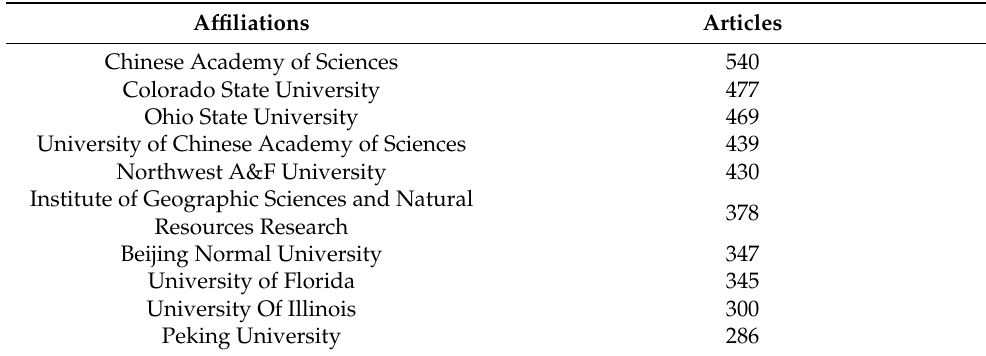
Table 3. Top 10 Research Institutions in Terms of the Impact of Land Use Change on Soil Carbon Sequestration from 1985 to